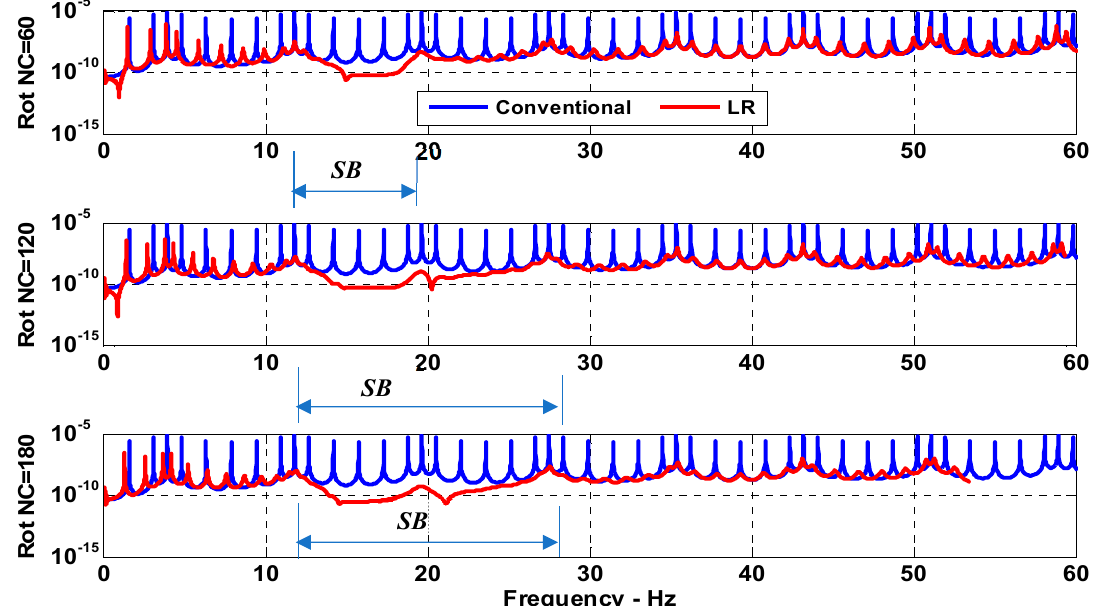
Figure 11. Comparisons between the torsional frequency response characteristics of a conventional drill-string and a drill-string, with periodic LR inserts for a different number of inserts when the VEM has a constant storage modulus ( SB: Stop band).